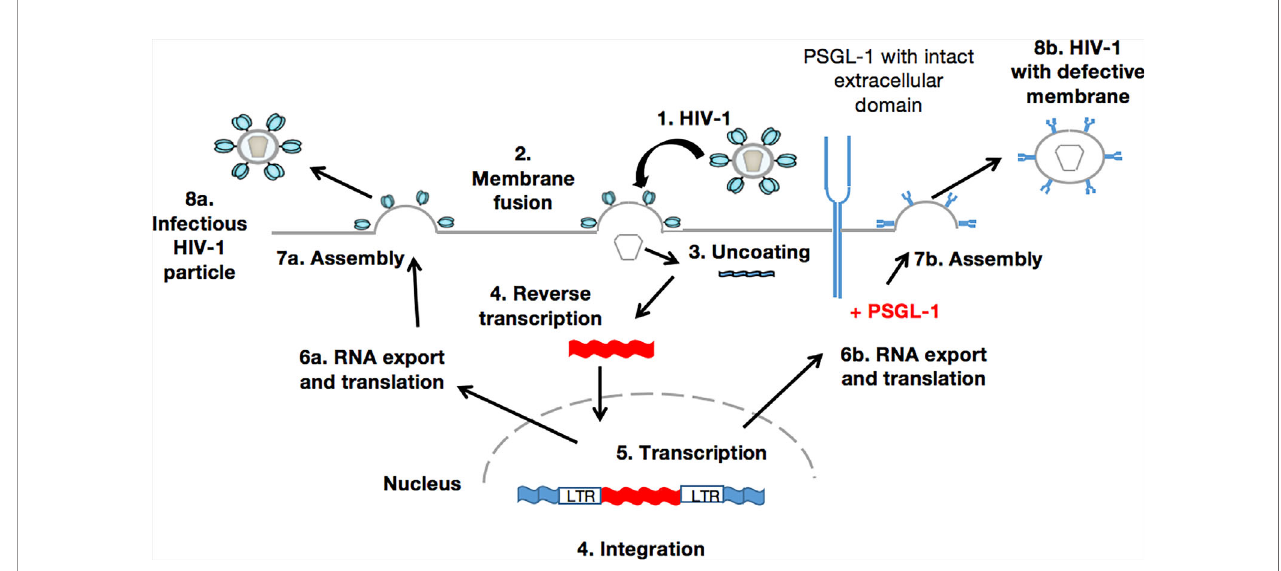
FIGURE 2 | PSGL-1 mediates the production of membrane defective HIV-1 particles. The infected target cell (1-5) produces viral RNAs and proteins that are normally assembled (6a-8a). These new viral particles can infect new cells in which the HIV-1 replication cycle would therefore take place. Conversely, in the presence of PSGL-1 (6b-8b), novel viral particles possess a defective membrane within which PSGL-1 is incorporated. Such a phenotype leads to the production of membrane defective virions that, in the absence of crucial elements such as gp120 and gp41, are unable to attach to or infect new target